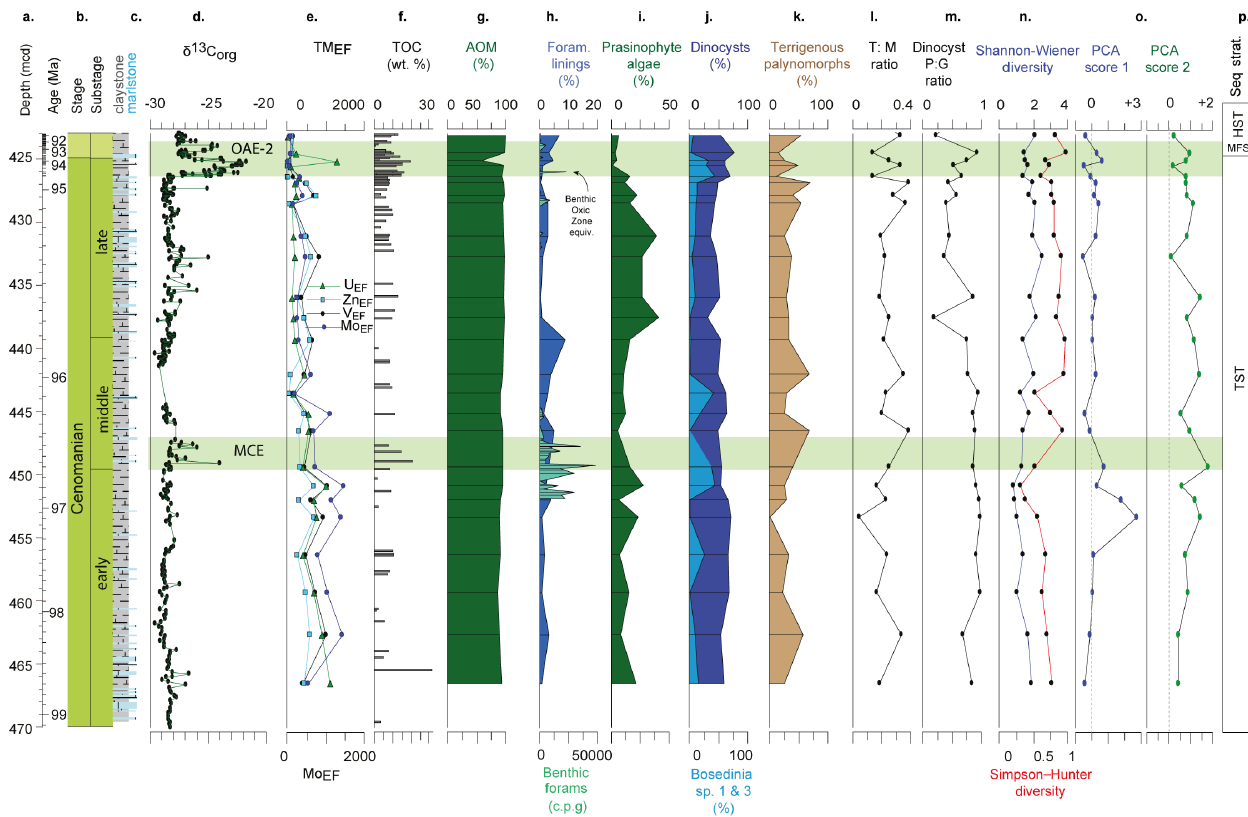
Figure 9. ODP Site 1260 data. Legend same as Fig. 4. δ 13 C org data from Erbacher et al. (2005); Friedrich et al. (2008). Benthic foraminiferal abundance data from Friedrich et al.